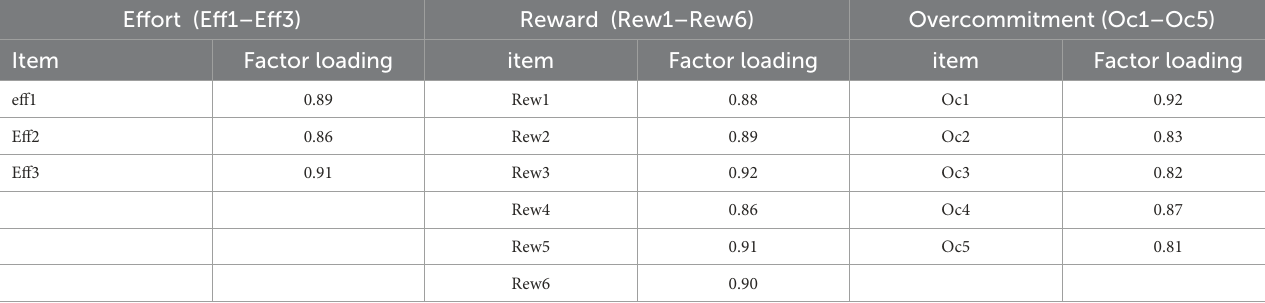
TABLE 1 Factor load of each item—Results of exploratory factor